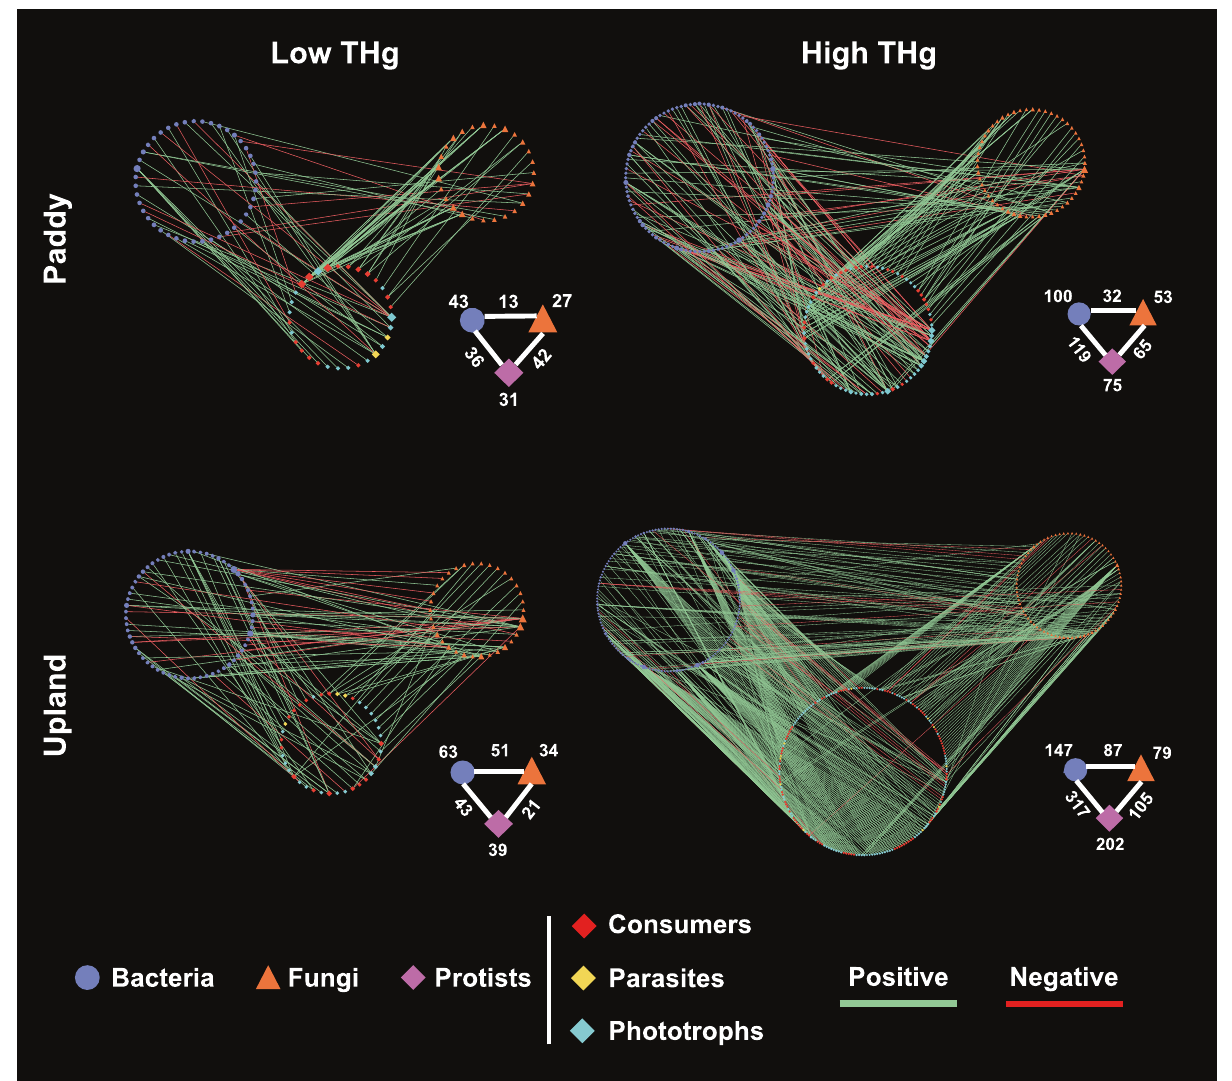
Fig. 4 The inter-kingdom networks visualizing Hg pollution effects on the co-occurrence patterns between soil communities. Node shapes (circle, triangle, and lozenge) and colors (blue, orange, and violet) represent microbial groups (bacteria, fungi, and protists), respectively. Node colors of protists (red, cyan, and yellow) represent trophic guilds (consumers, phototrophs, and parasites), respectively. Node size is proportional to the degree, with a larger node having a higher degree. Edge colors represent positive (green) or negative (red) connections between microbial